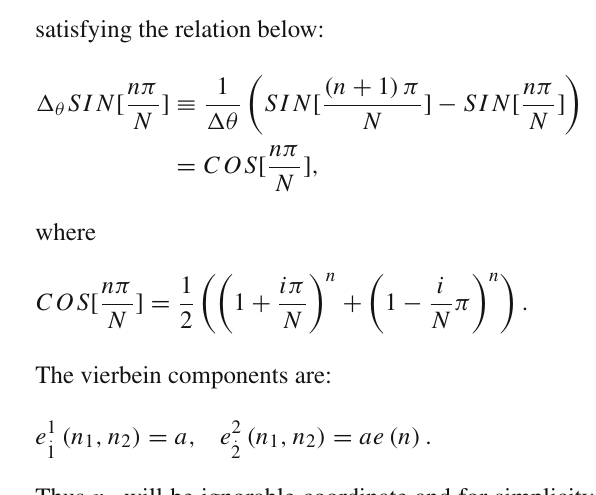
where θ is the step function θ ( x ) = 1 , x > 0 and θ ( x ) = 0 for x < 0